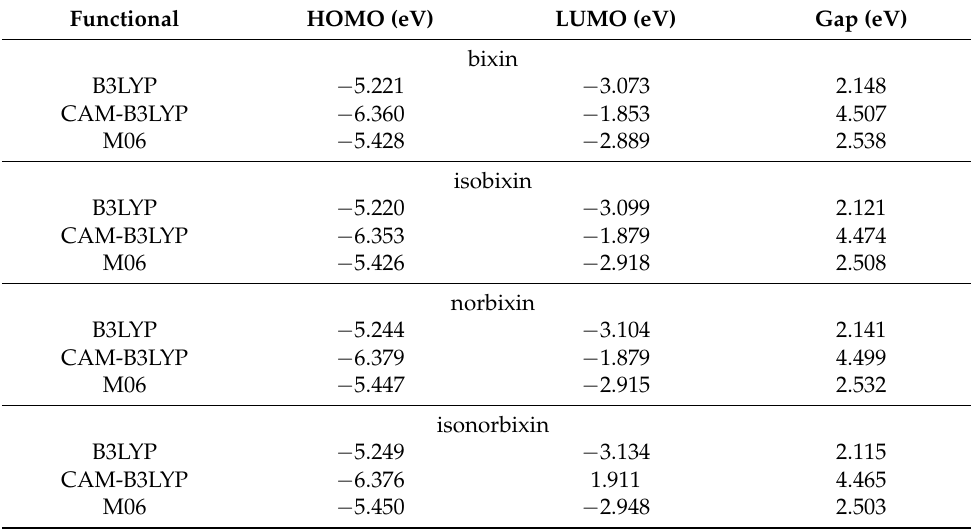
Table 2. Frontier HOMO/LUMO MOs and gap energy values for the dyes in chloroform solution. These results were obtained by employing the 6-31+G(d,p) basis